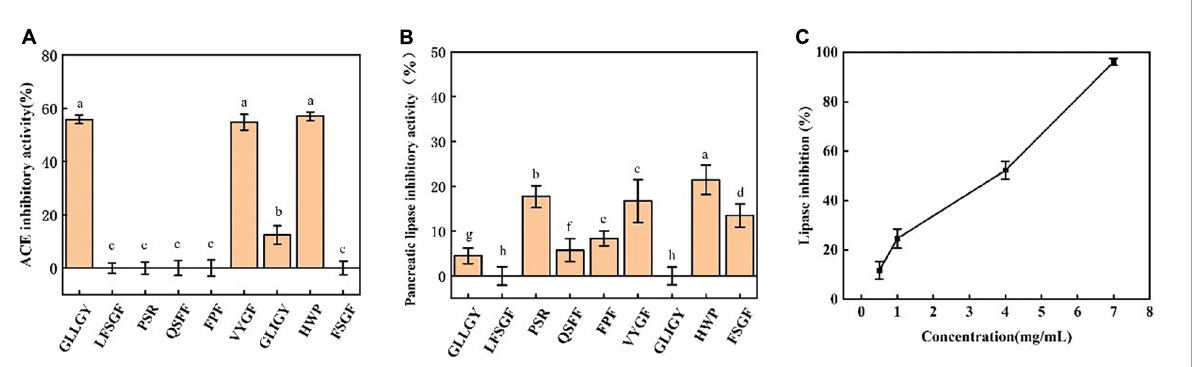
FIGURE1 (A) The ACE inhibitory activity of peptides. The pancreatic lipase inhibitory activities of (B) peptides and (C) HWP. The small letters represent the significant difference p <